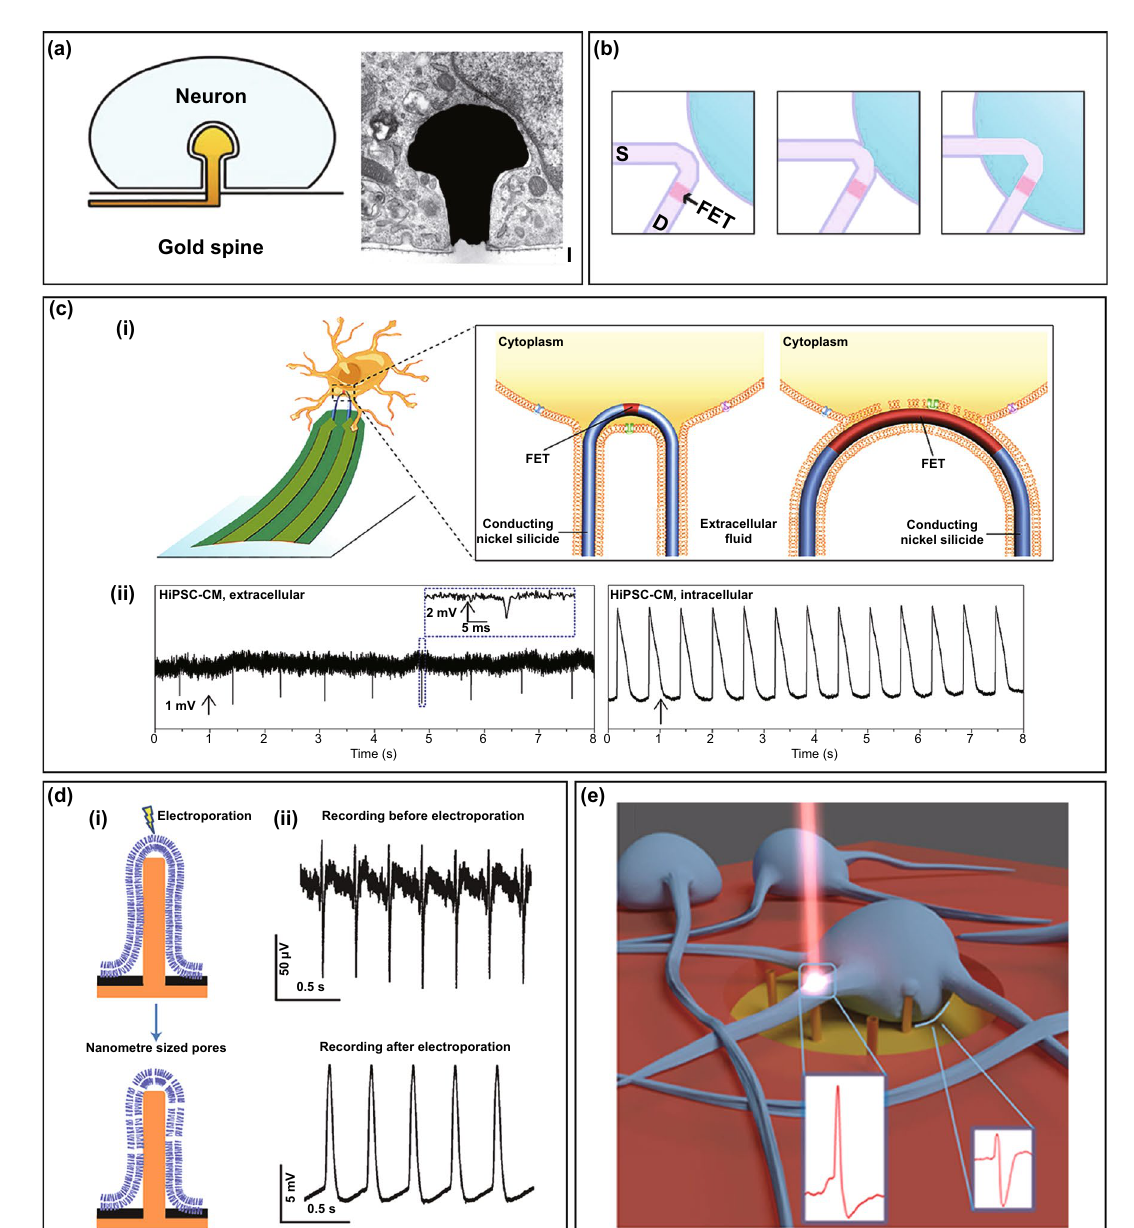
Fig. 3 Methods for obtaining intracellular access. a Schematic illustration and SEM image of the neuron engulfing a gold-spine electrode. Reproduced with permission from Ref. [97]. Copyright 2010, Nature. b Schematic illustration of nanowire probe entrance into a cell. Dark pur- ple and blue colours denote the phospholipid bilayers and cytosol, respectively. Reproduced with permission from Ref. [87]. Copyright 2010, American Association for the Advancement of Science. c (i) Schematic illustration of U-shaped nanowire probe with different radii of curva- ture (ROC) to permeate cellular membrane. (ii) Extracellular and intracellular recording from the nanoprobe with 1.5 μm ROC and 0.75 μm ROC, respectively. Reproduced with permission from Ref. [109]. Copyright 2019, Nature. d (i) Schematic illustration of the electroporation by a nanopillar electrode. (ii) The electrical signals recording before and after electroporation. Reproduced with permission from Ref. [91]. Copy- right 2012, Nature. e Schematic illustration of plasmonic optoporation by MEA with 3D nanoelectrodes. Reproduced with permission from